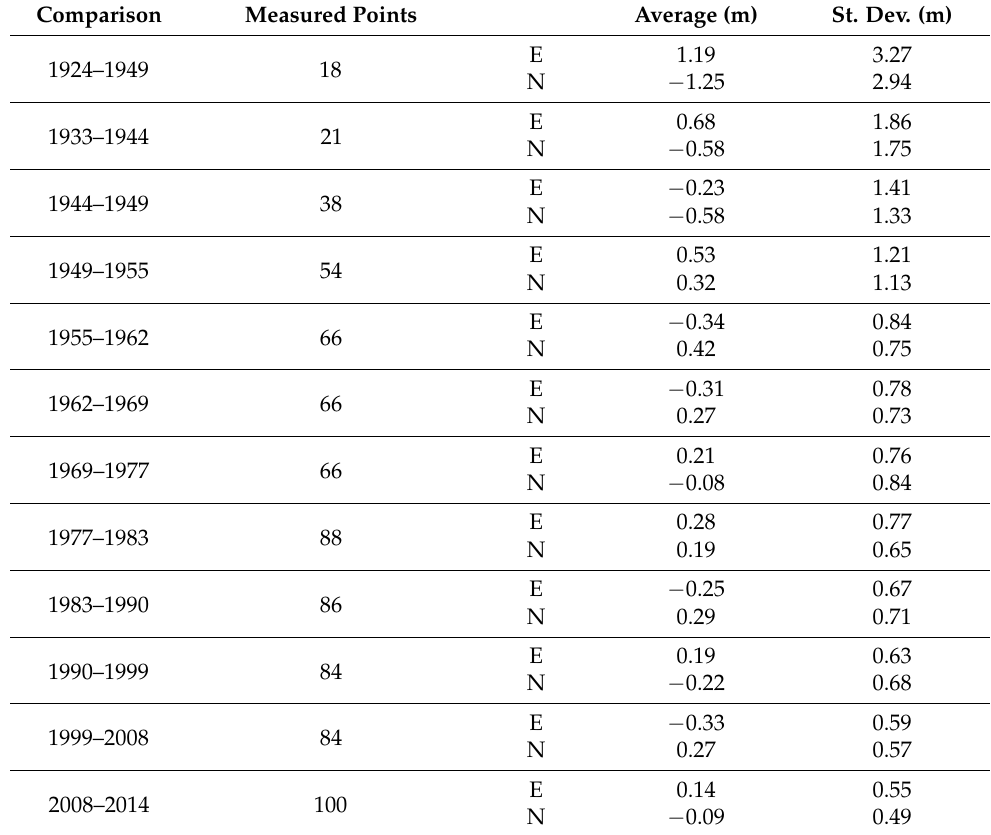
Table 3. Comparisons between coordinates of homologous natural points, manually measured on archival cartography, photo-plans, and photogrammetric models (for the last, using stereoscopic viewing devices) (E: East; N: North; St. Dev.: Standard Deviation).